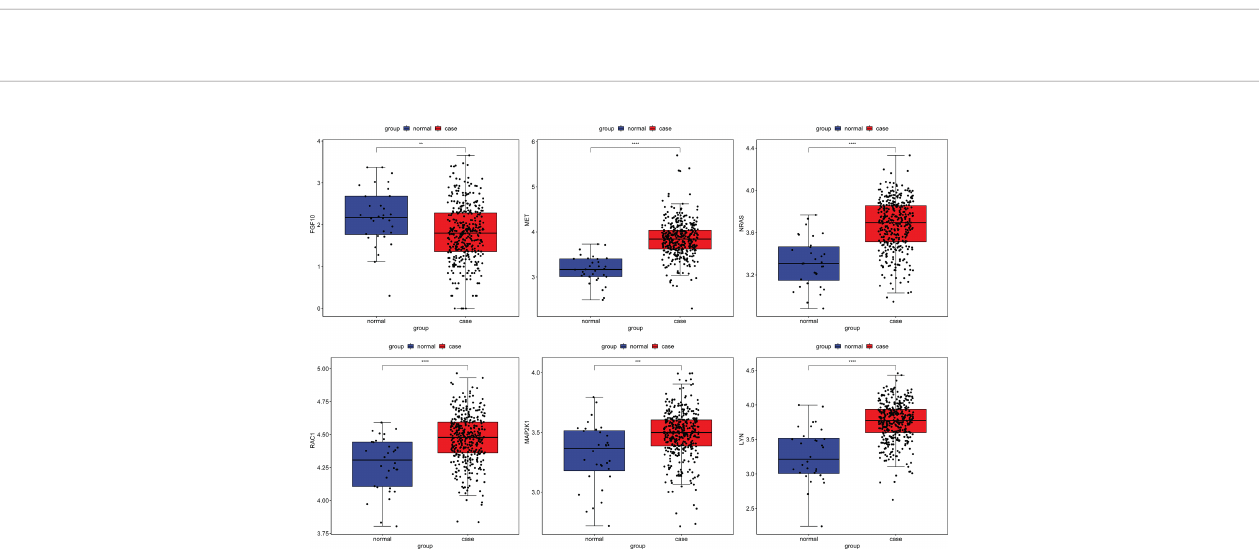
FIGURE 12 | Expression validation of FGF10, MET, NRAS, RAC1, MAP2K1, and LYN in the TCGA dataset. ** p < 0.01; *** p < 0.001; **** p <